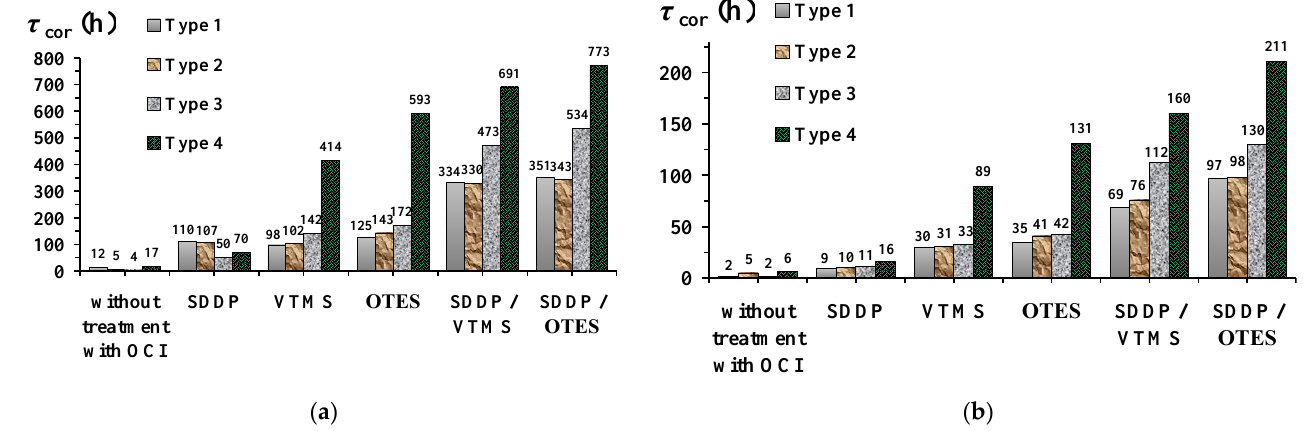
Figure 3. τ cor values ( a ) in the heat and moisture chamber and in a salt spray chamber ( b ) on “smooth” (Type 1) and textured (Type 2–4) zinc samples with subsequent treatment in SDDP and TASs solutions. The concentrations of OCI solutions are given in mM. Table 4. γ and Z values calculated based on the results of corrosion tests in aggressive atmospheres of zinc samples with different surface morphology, treated in SDDP and TASs solutions. Composition of the Inhibiting Solu-